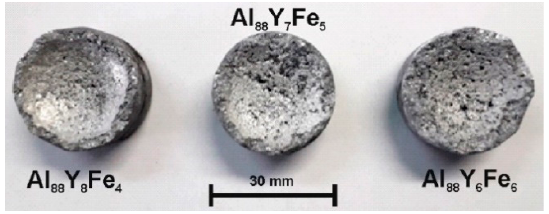
Figure 1. External morphology of Al 88 Y 8 Fe 4 , Al 88 Y 7 Fe 5 , and Al 88 Y 6 Fe 6 alloys in the form of ingots . The structure of ingots and melt-spun alloys was investigated by X-ray diffraction (XRD) and Mössbauer spectroscopy (MS). X-ray diffraction patterns were recorded for samples in a form of powder by 2 θ angular range from 10 ◦ to 90 ◦ . Phase analysis